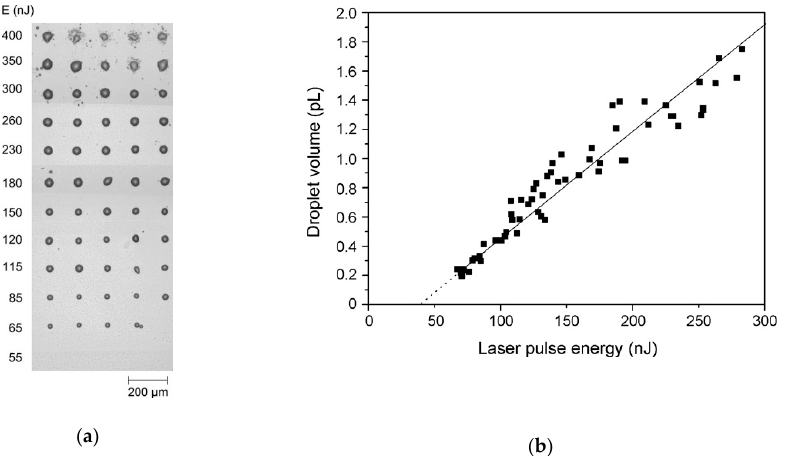
Figure 4. ( a ) Optical microscopy image of droplets printed by LIFT at different laser pulse energies (indicated on the left of each row). ( b ) Plot of the volume of the droplets printed in ( a ) vs. the laser pulse energy. Reprinted from [31] with permission of Elsevier.